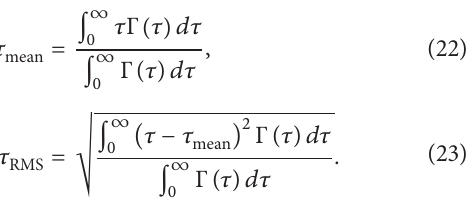
and 𝜏 function of mobile position. mean RMS